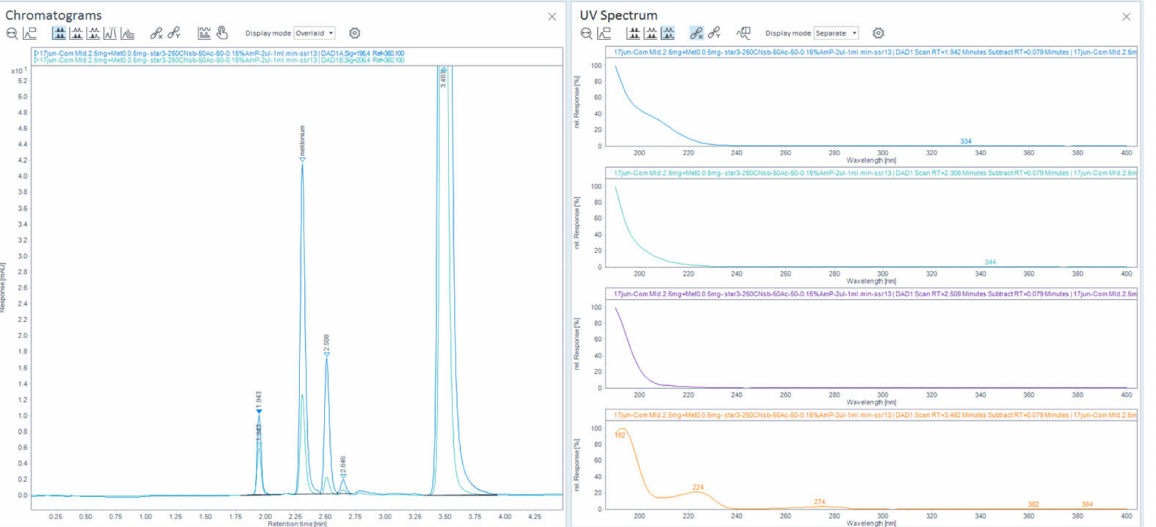
Figure 36. Chromatograms, eluted with 50% ACN and 50 % 13 mM NH 4 H 2 PO 4 , were recorded and overlaid at 2-channels of 195 nm and 205 nm overlaid are on the left and their characteristic UV-spectrums on the right. The second peak is meldonium on chromatogram, and the last highest peak was metoprolol, third and fourth peaks were new appeared. From the 4 presented UV-Abs spectrums, the second from the top was the meldonium peak extracted and fourth at the bottom was of metoprolol.